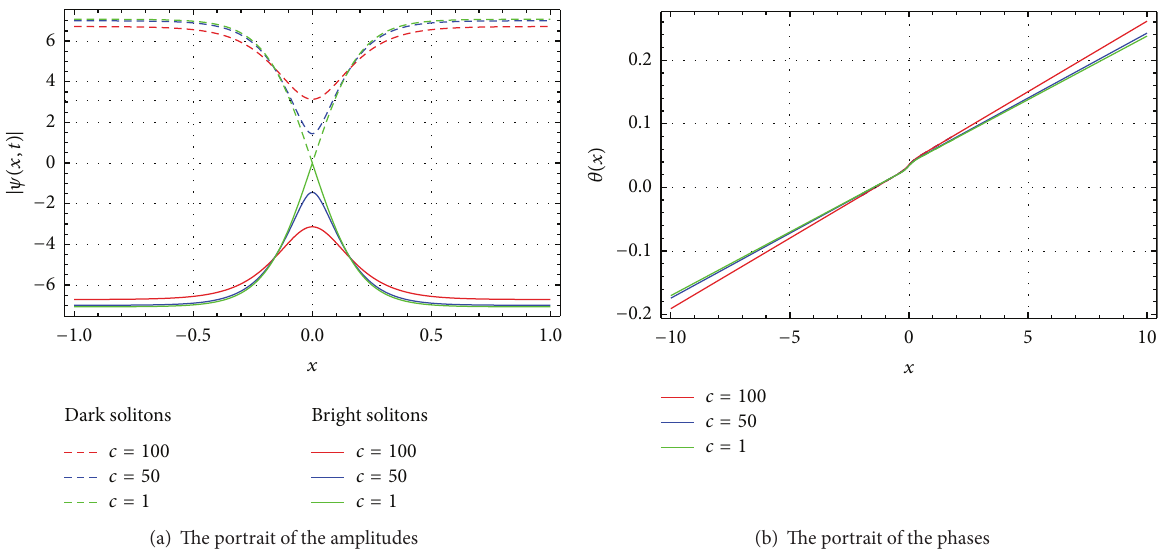
Figure 3: Dynamical evolution of the dark and bright solitons for an attractive condensate with 𝑔 = −1 , 𝛿 = 50 . With the increasing of 𝑐 (“angular momentum”), the height of solitons decreases. The phase is monotonously increasing with respect to the spatial 𝑥 .